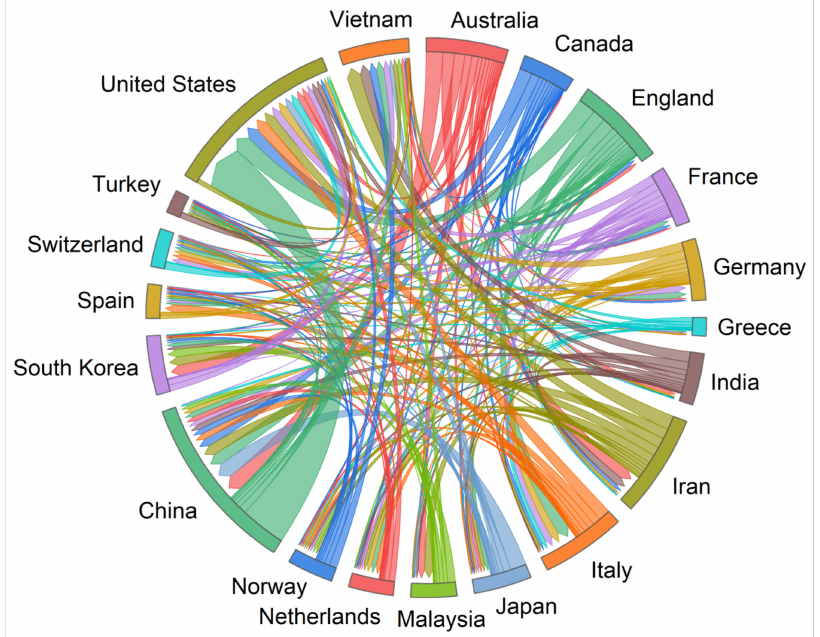
Figure 6. Cooperation between countries and